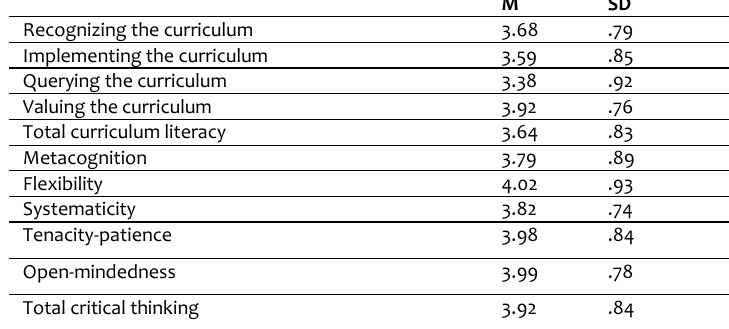
Table 2. Descriptive values for curriculum literacy and critical thinking